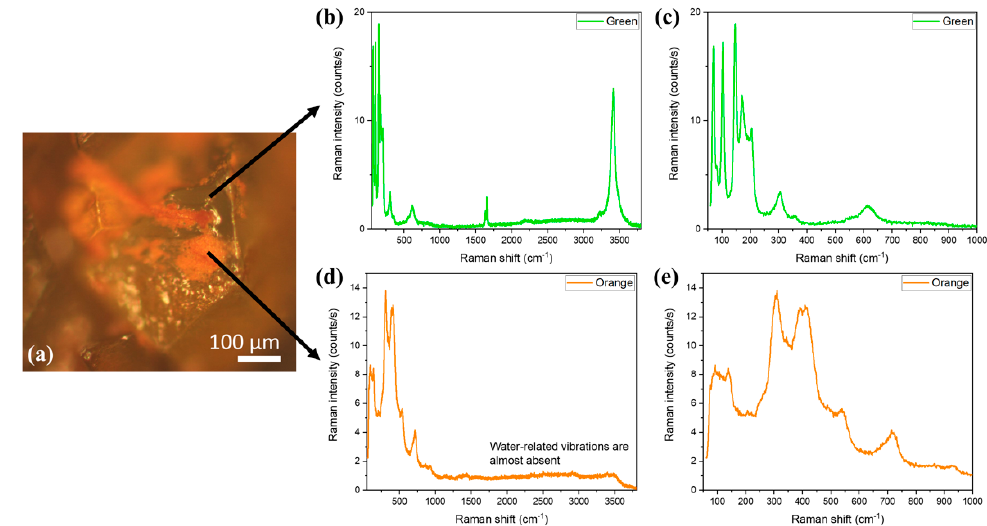
Figure 8. Micro-Raman spectra recorded on AFC sample. ( a ) Optical micrograph of a crystal, showing the regions where the spectra were taken. ( b , c ) Raman spectra measured on the green region. ( d , e ) Raman spectra recorded on the orange region.